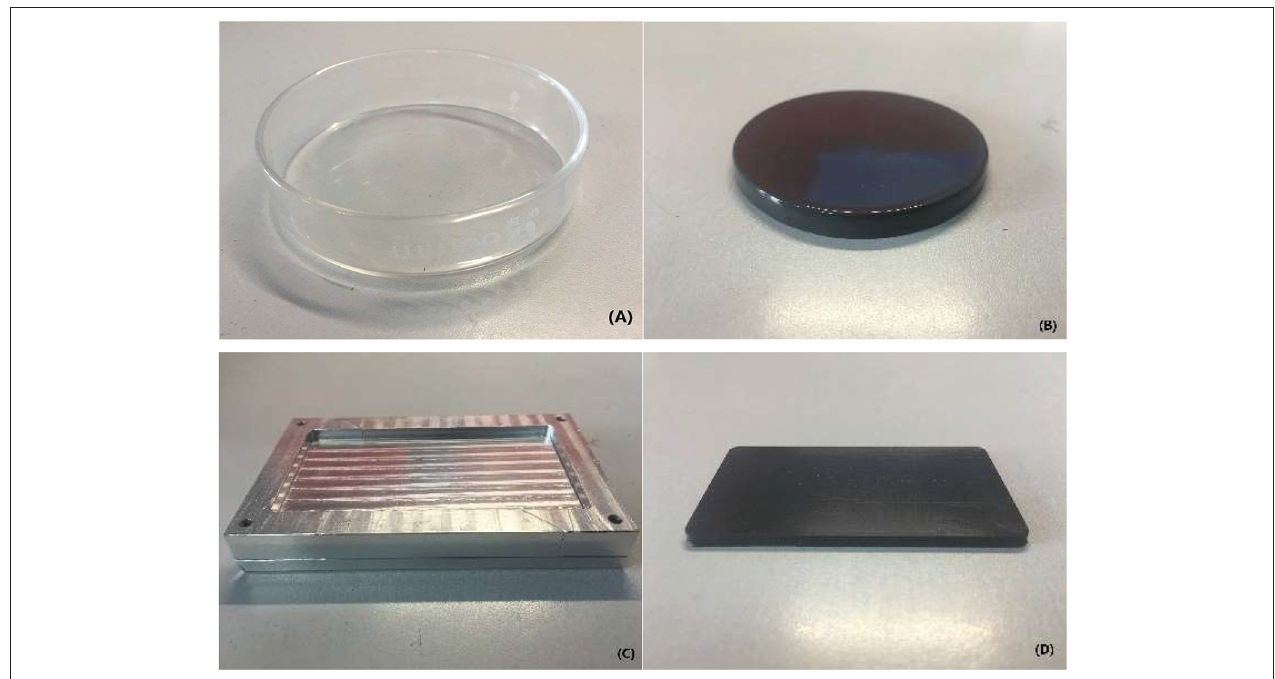
FIGURE 4 | MRE samples (A) the glass mold (B) the MRE generated in glass mold (C) iron mold (D) the MRE generated in iron mold.